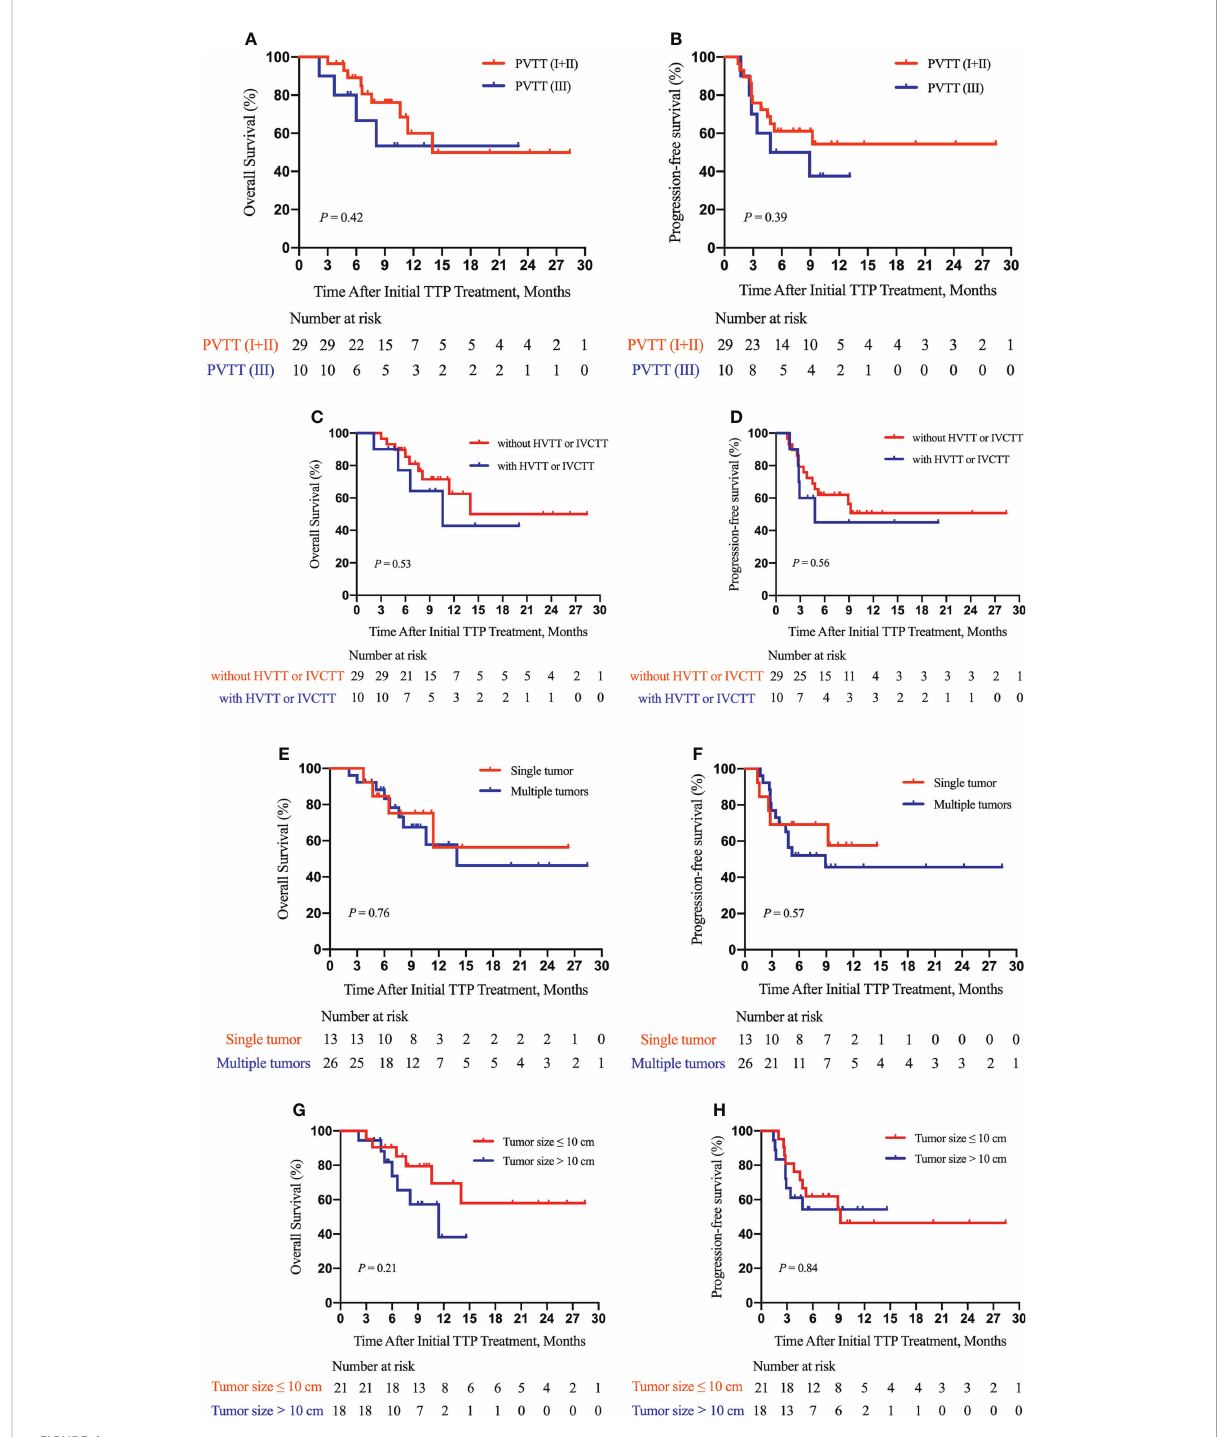
FIGURE 4 Subgroup survival analysis according to the type of PVTT, the presence or absence of hepatic vein tumor thrombus (HVTT)/inferior vena cava tumor thrombus (IVCTT), the tumor number, and tumor size. Subgroup analysis of OS (A) and PFS (B) according to the type of PVTT; a subgroup analysis of OS (C) and PFS (D) according to the presence or absence of HVTT/IVCTT; a subgroup analysis of OS (E) and PFS (F) according to the tumor number; a subgroup analysis of OS (G) and PFS (H) according to tumor size. TTP, TACE plus anti-angiogenic-targeted treatment and anti-PD-1 inhibitors; PVTT, portal vein tumor thrombus; HVTT, hepatic vein tumor thrombus; IVCTT, inferior vena cava tumor